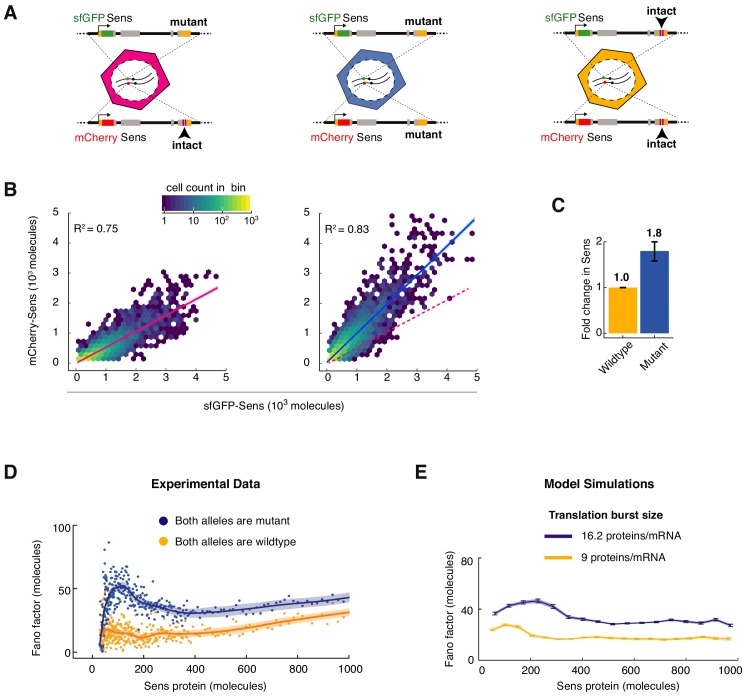
MicroRNA regulation uniformly decreases Sens protein output and noise.(A) The sens transgenes were modified to mutate the two miR-9a binding sites in the 3’UTR. Wing disc cells were generated that had different combinations of mutant and wildtype alleles. (B) Protein output measured from the mCherry-sens allele with intact (left plot) or mutated (right plot) miR-9a sites. These were measured relative to protein output from the sfGFP-sens allele with mutated sites. A sample of 6,000 cells is shown for each plot, and colors represent cell density in the plotted hexagonal bins. Lines represent the linear regression model fit and shaded regions are the 95% confidence intervals. Dotted red line in right plot shows fit from the left plot. Since the linear model fits both genotypes equally well, it argues that the strength of miR-9a repression is equivalent in all cells, regardless of Sens output. (C) Sens protein output increases with loss of miR-9a binding sites. Error bars are standard error of the mean. Shown is the comparison of mutant sfGFP-sens to wildtype mCherry-sens but the same result was observed if the mutant mCherry-sens was compared to wildtype sfGFP-sens (Figure 4—figure supplement 1). (D) Loss of miR-9a regulation leads to an increase in Fano factor across the entire range of Sens protein output. Shaded regions are 95% confidence intervals. (E) Model simulations with a 1.8-fold increase in translation burst size (defined as Sp/Dm) reproduces the experimentally observed Fano profile. Error bars are 95% confidence intervals.